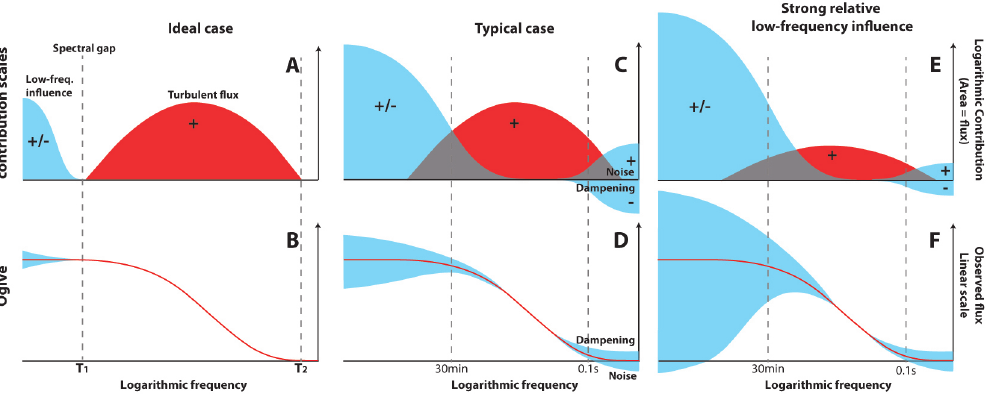
Figure 1. A number of typical observational situations shown in terms of co-spectra (top row) and ogives (bottom row). Shown are the turbulent fluxes (red) and low-frequency/noise/dampening components